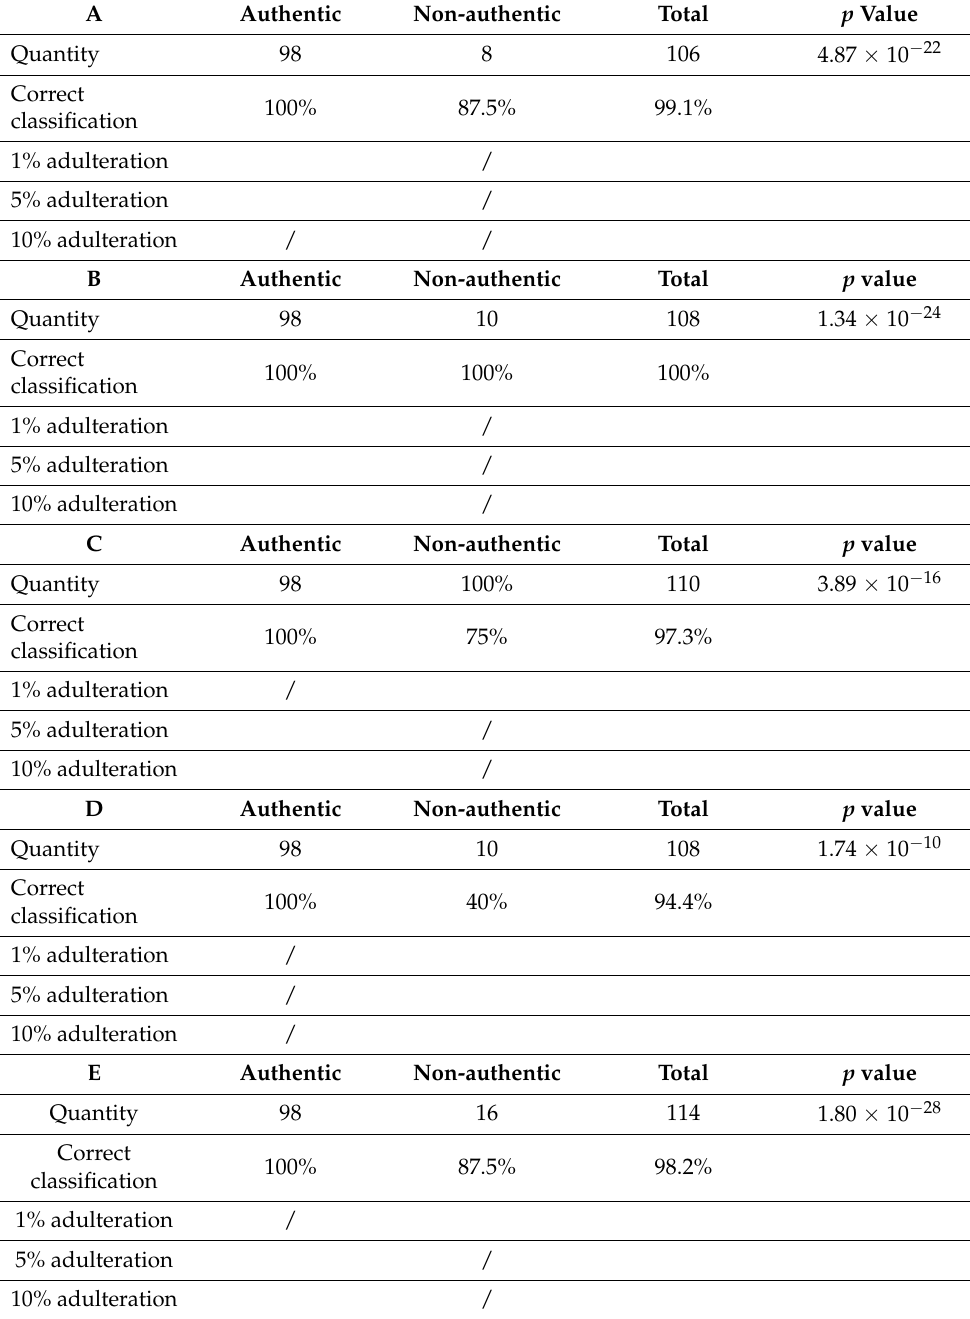
Table 5. Misclassification table from a two-class OPLS-DA model applied to a prediction set of authentic and non-authentic EBNs using MIR spectra (A: melamine, B: karaya gum, C: gelatine, D: collagen and E: nutrient agar). In the first row, the first column is the classes of the model, and the last column is the p value (<0.05) which represents the significance of the classification model. The second and third column is the total number of samples in each class and their respective individual number of correct classifications. The last three rows indicate the correct classification of adulterated EBNs into non-authentic EBNs or incorrect classification into authentic EBNs